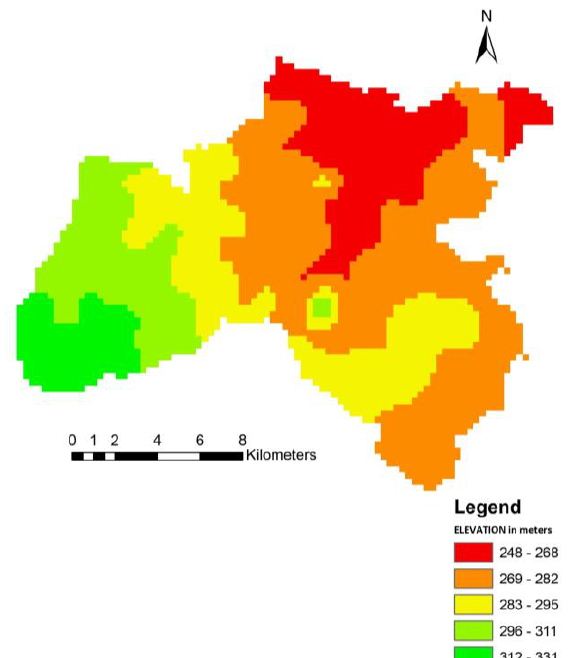
Fig. 3a. Contour map with 10 m contour interval